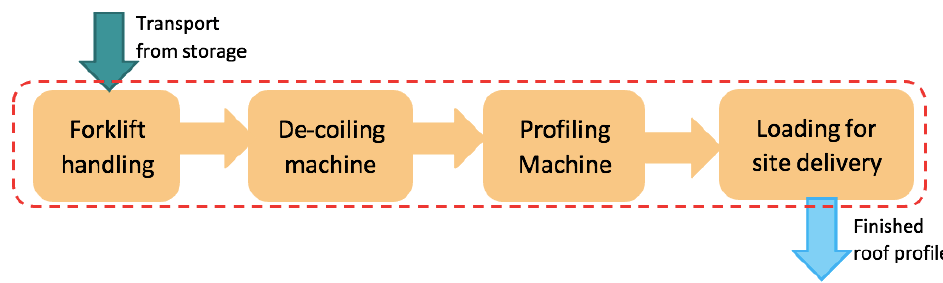
Figure 4. Overview of the factory production aggregate process.